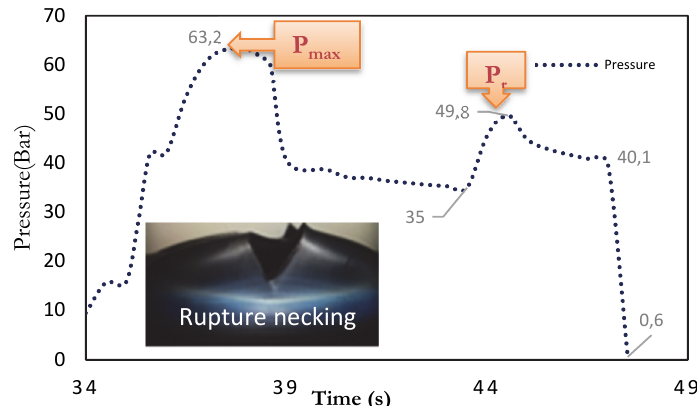
Figure 4: Internal pressure evolution as a function of the time.